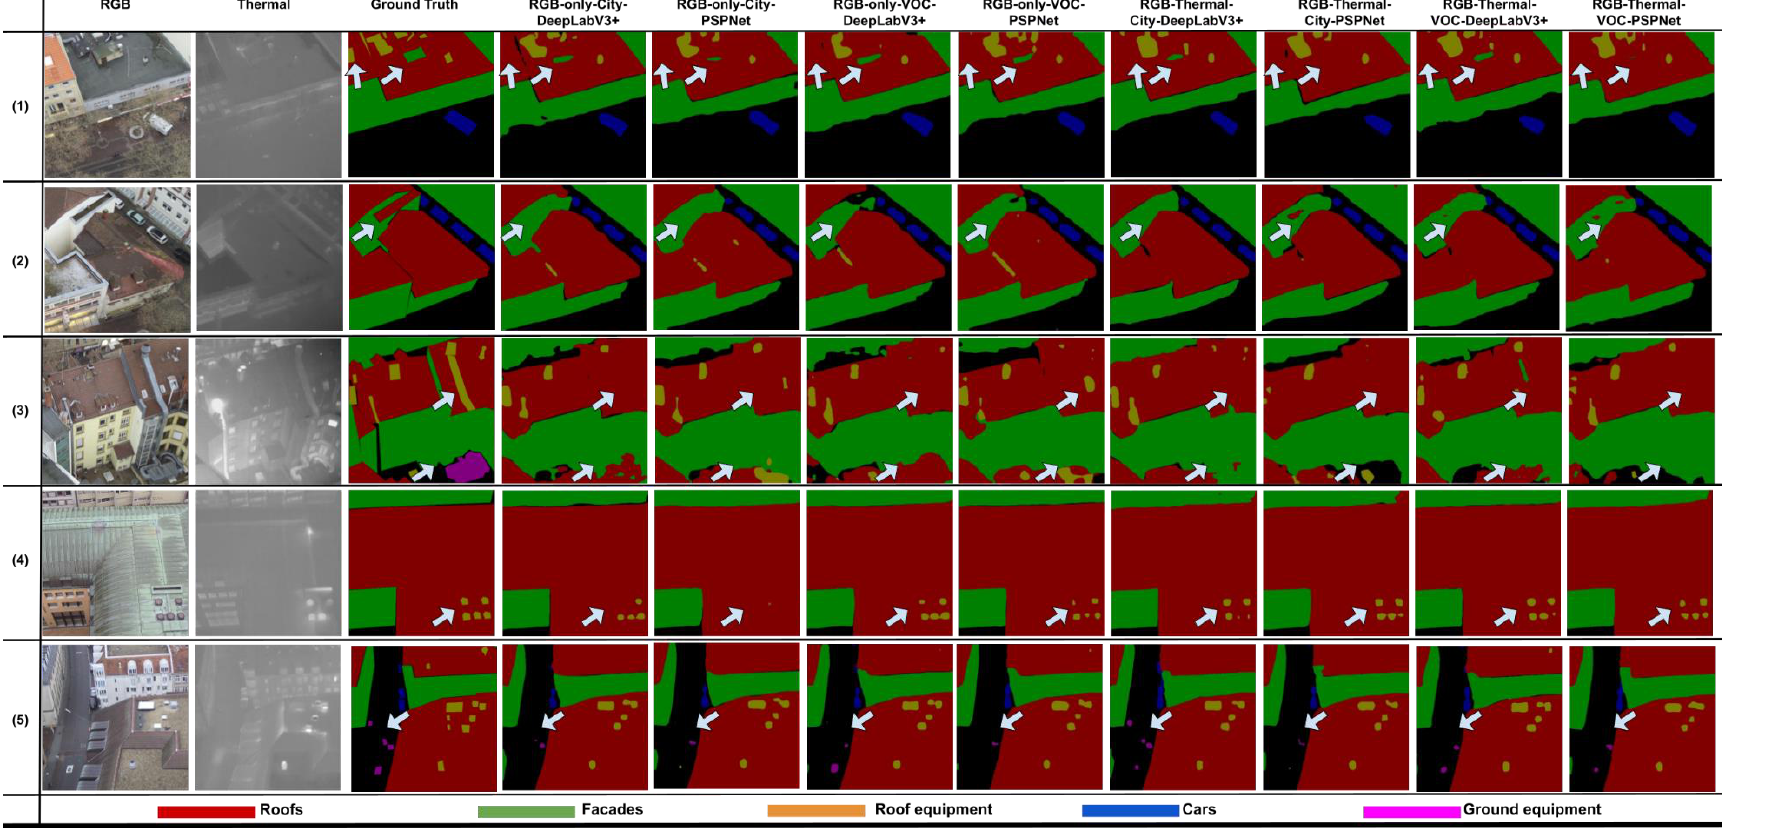
Figure 5. Semantic segmentation detected by algorithms.